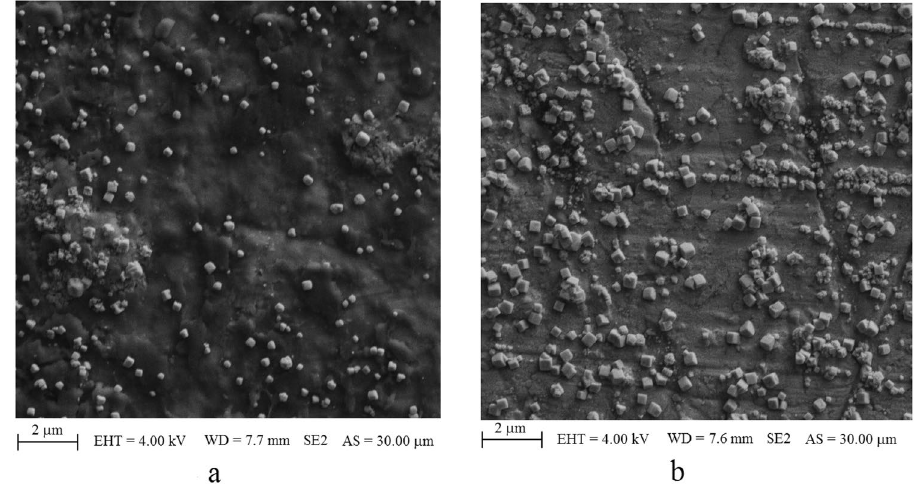
Figure 3. SEM images of two different areas from anode surface after 5 minutes of electrolysis while the container was filled with ultra-pure water.